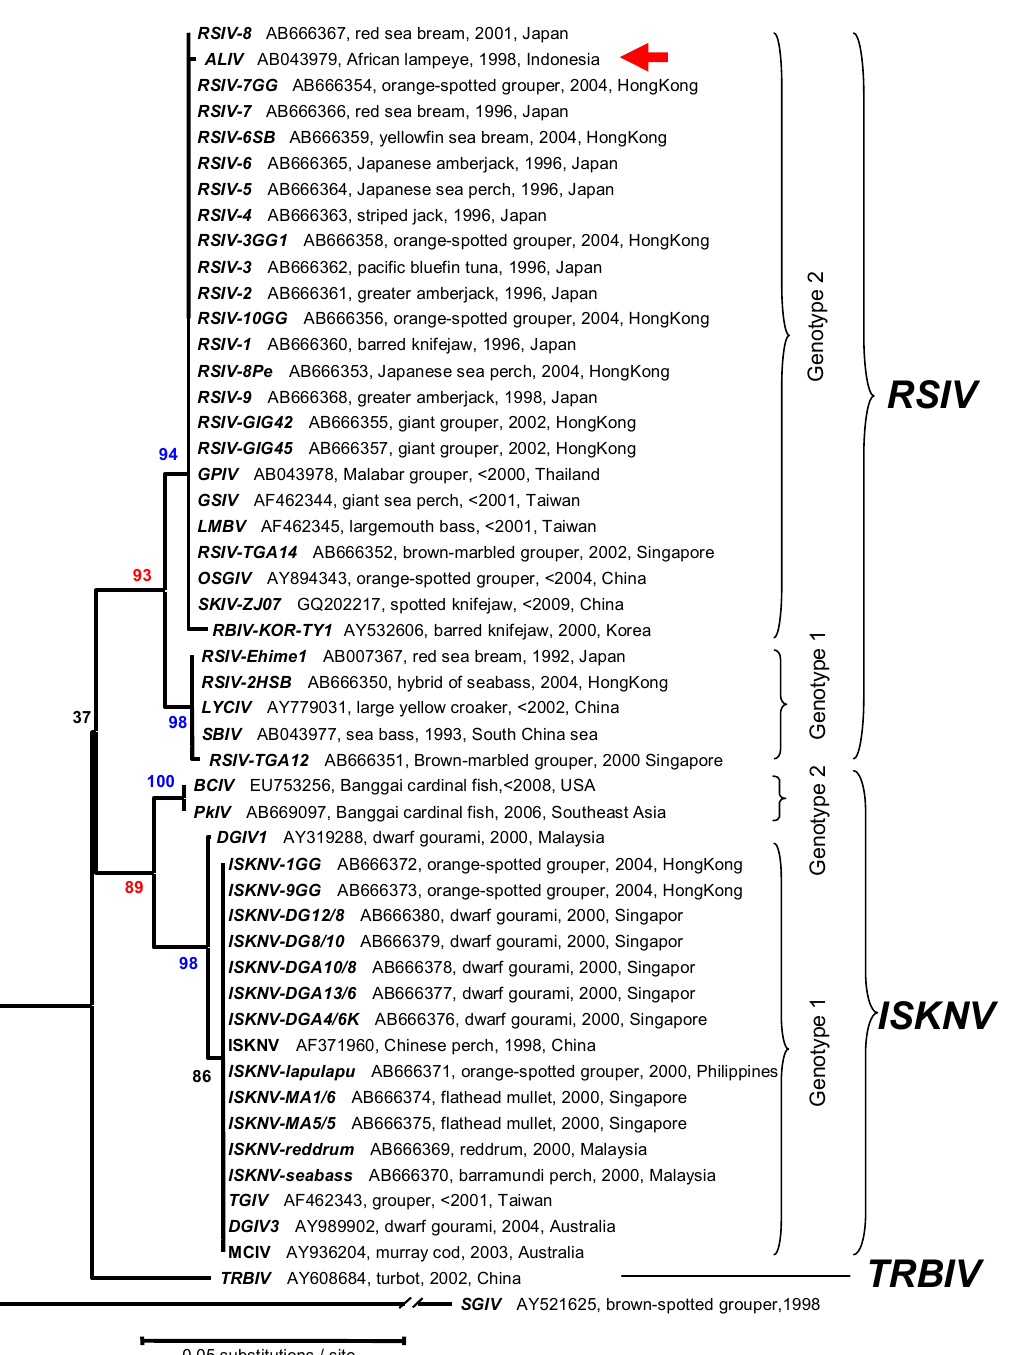
Figure 7. Phylogenetic analysis. This tree, based on the megalocytivirus ATPase gene, was constructed as described in the legend to Figure 6. Accession numbers, host, year sampled, and locations are attached to each